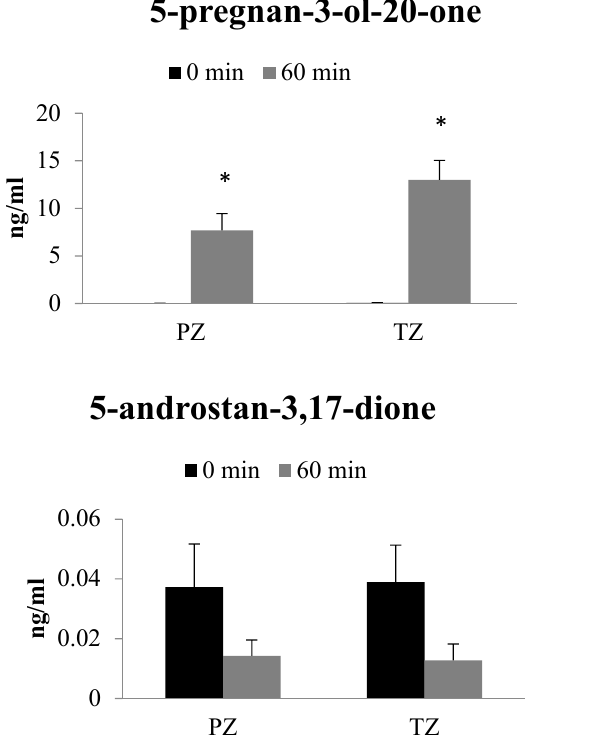
Figure 2. Steroidogenesis in peripheral zone (PZ) and transition zone (TZ) of human prostate cancer tissues following incubation with progesterone (2 µg/mL). Results are expressed as mean ± SEM (PZ n = 9; TZ n = 15). * indicates statistically significant differences ( p < 0.05) between 0 min and 60 min incubations with respective tissue zones.